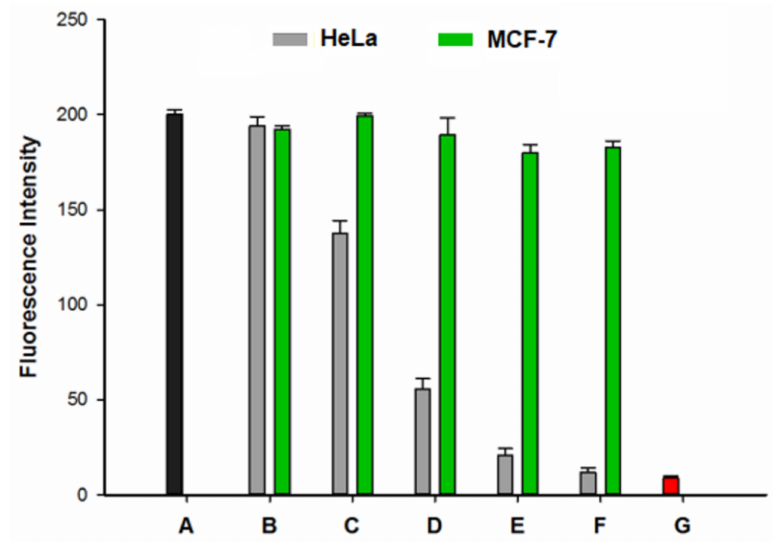
Figure 3. Fluorescence spectra of the solution containing G3MB1-F, ThT and Exo III after incubation with varying concentrations of HeLa cells or MCF-7 cells, (A) G3MB1-F + ThT + Exo III, (B–F) the G3MB1-F treated with HeLa cells or MCF-7 cells, different cell numbers were 1 × 10 3 , 5 × 10 3 , 1 × 10 4 , 5 × 10 4 and 1 × 10 5 . (G) G3MB1-F + ThT. The excitation wavelength was set at 435 nm, and the fluorescence spectra were collected from 460 nm to 600 nm at room